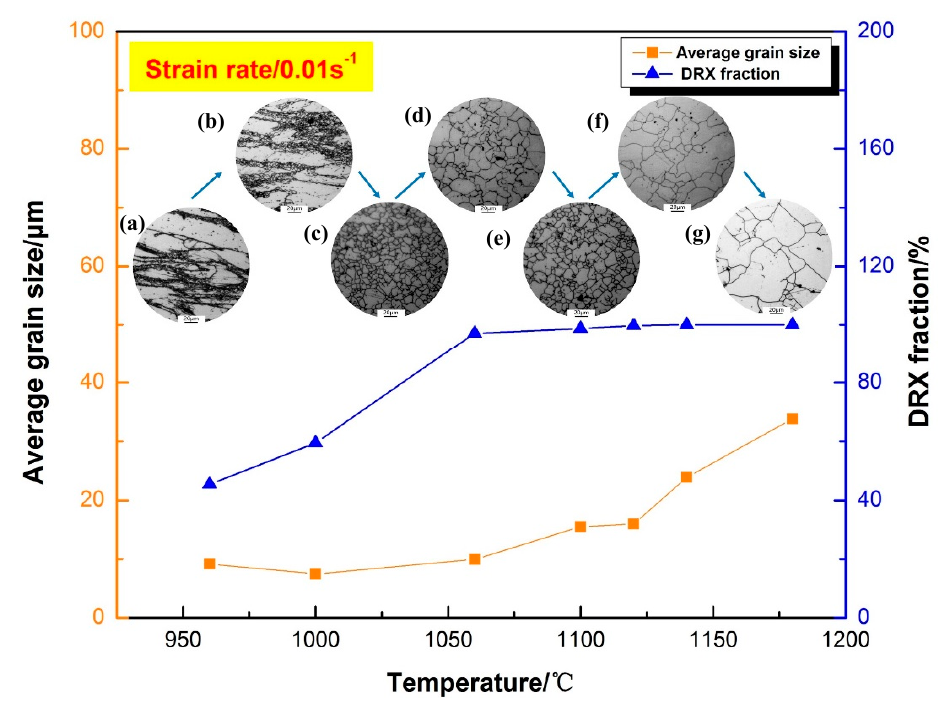
Figure 11. Schematic diagram of grain size, DRX fraction and optical microstructure of the specimens deformed at the strain rate of 0.01 s − 1 : ( a ) 960 °C, ( b ) 1000 °C, ( c ) 1060 °C, ( d ) 1100 °C, ( e ) 1120 °C, ( f ) 1140 °C, ( g ) 1180 °C.